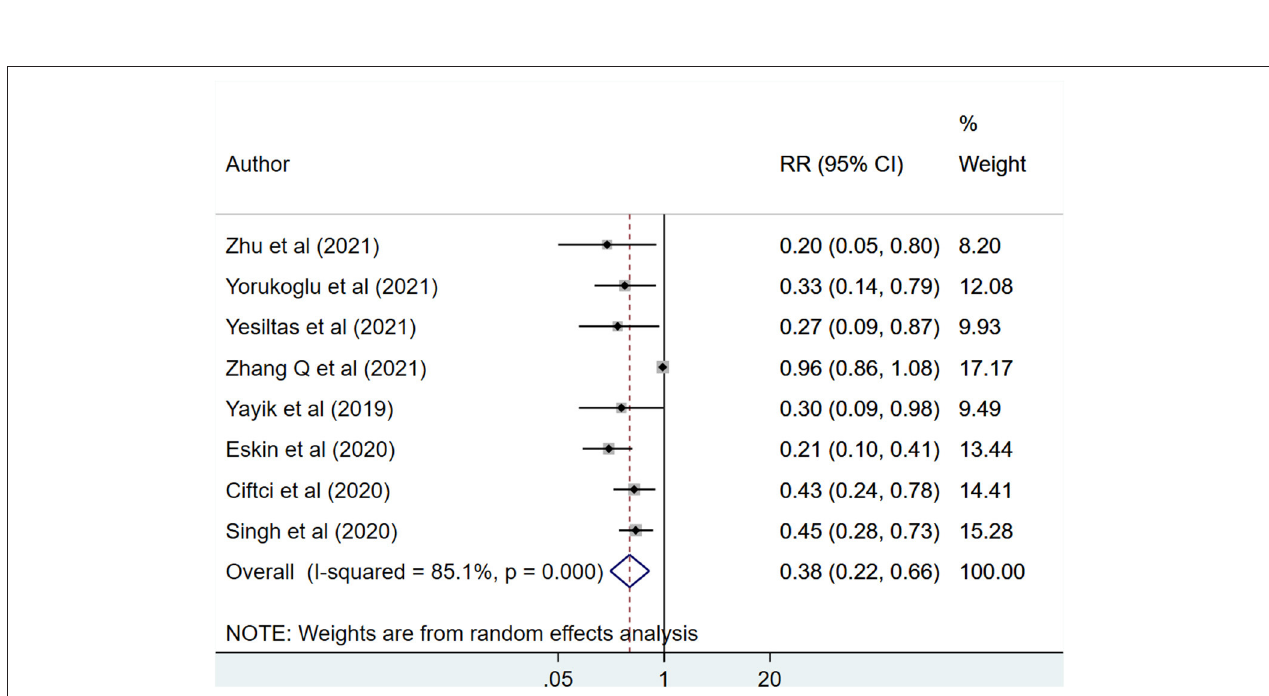
Frontiers in Surgery |